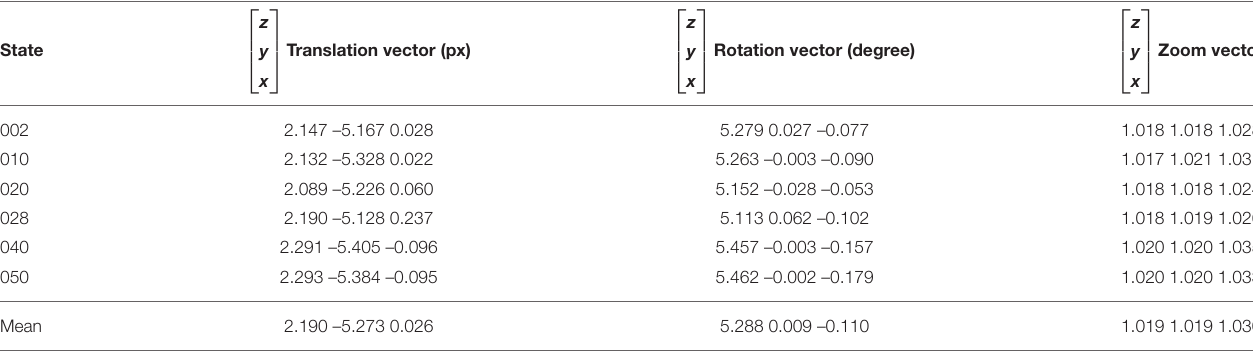
TABLE 1 | Results of multiplicative polar decomposition of different 8 into translation, rotation, and “zoom” components to register µ n fields onto µ x fields for different imaged states.